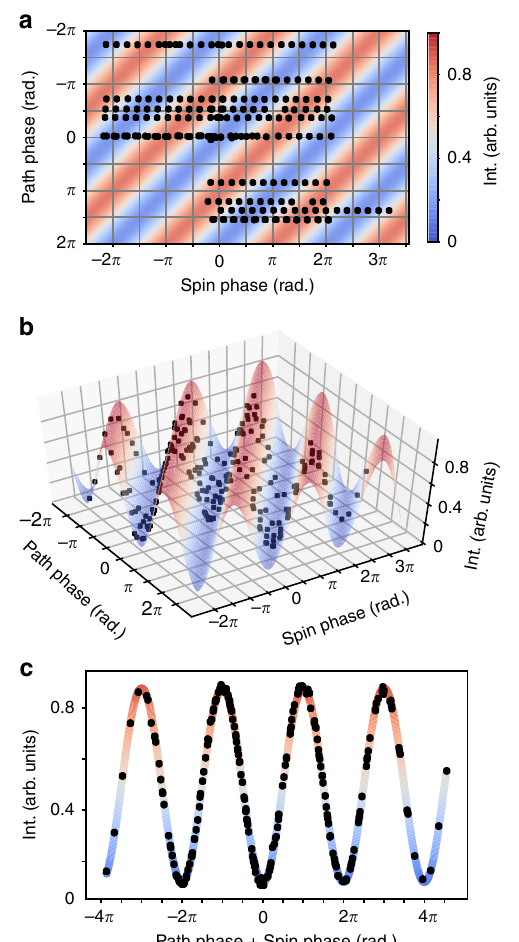
Fig. 2 Measured path and spin phases. a The black circles indicate the path and spin phases where measurements were taken at a neutron wavelength of 0.4 nm. The colored stripes illustrate the cosine curve fi tted to the data. b 3D view of the normalized intensities (black circles) plotted against the path and spin phases and fi tted by a cosine fi tting function. c Measured intensities and the fi tted cosine function plotted against the sum of path and spin phase. Error bars, representing standard deviations derived from counting statistics, are the size of the markers or smaller.